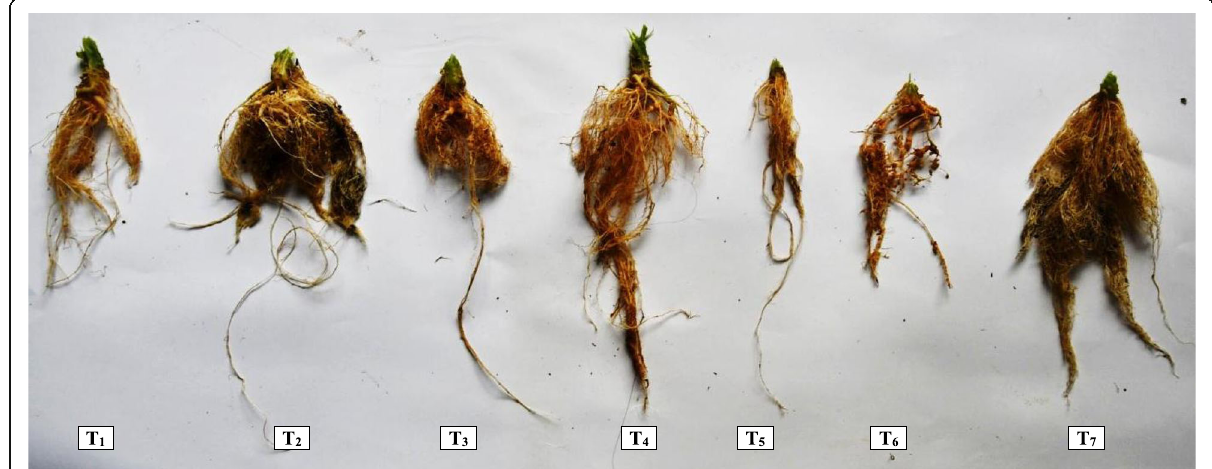
Fig. 3 Effect of Fictor composticola and organic amendments in different combinations on gall formation by Meloidogyne incognita on